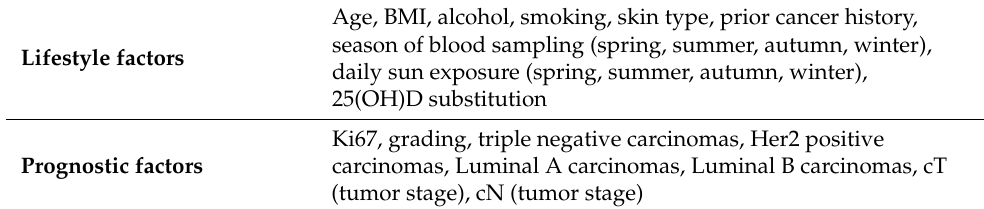
Table 7. Different lifestyle and prognostic factors were examined regarding an association to serum 25-hydroxyvitamin D